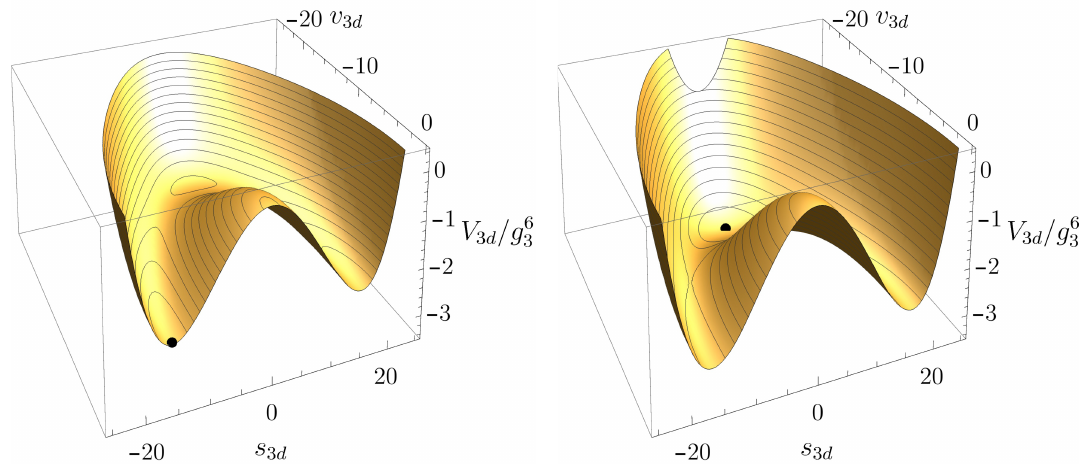
Figure 2 . Schematic illustration for two-step phase transition, showcasing the effective potential near the critical temperature ( T c ,φ ) of the second phase transition from singlet to Higgs phase. At T > T c ,φ (left), the minimum — depicted with a black dot — in singlet direction is global. At T < T c ,φ (right), the Higgs phase becomes energetically favorable and the system undergoes a second phase transition. Since the singlet and Higgs minima are separated by a barrier, the transition is of first order. This barrier exists already at tree-level and therefore the second transition can be strong and relevant for gravitational wave